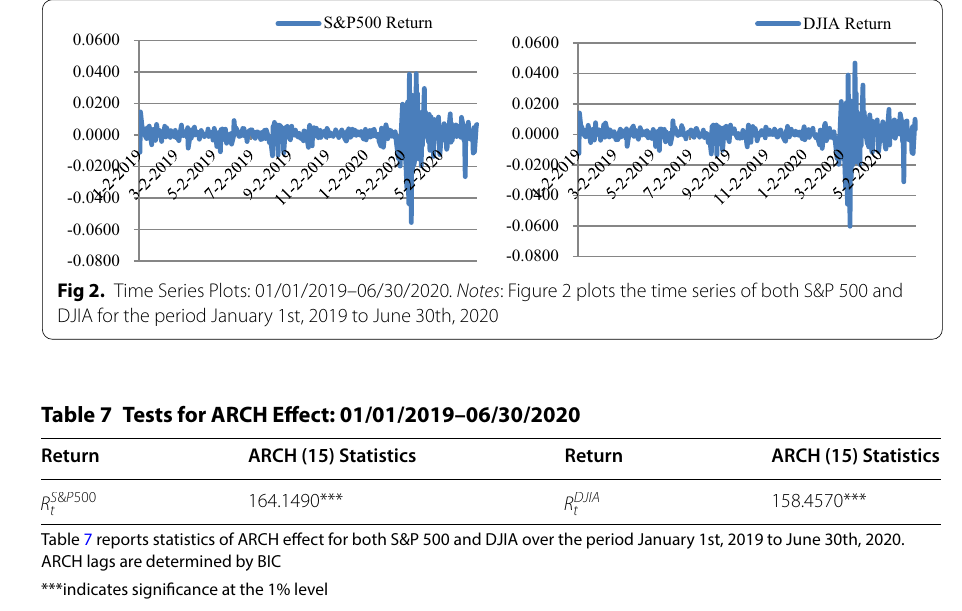
Table 7 reports statistics of ARCH effect for both S&P 500 and DJIA over the period January 1st, 2019 to June 30th, 2020. ARCH lags are determined by BIC ***indicates significance at the 1% level